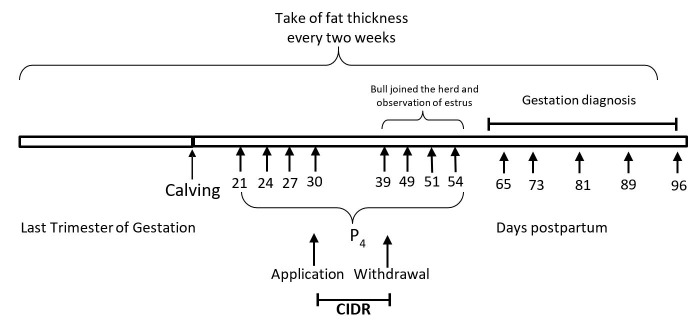
Timeline of specific experimental events with Bos indicus crossbred cows. P4: Day postpartum when the blood sample was taken to measure concentrations of progesterone.